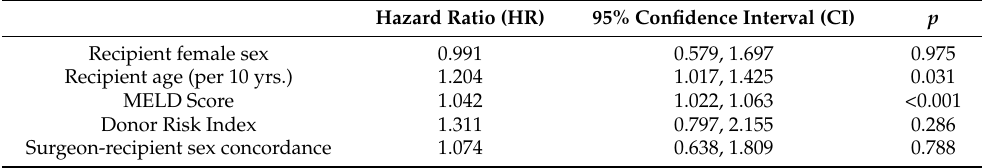
Table 4. Results from Cox regression analysis of factors independently associated with postoperative